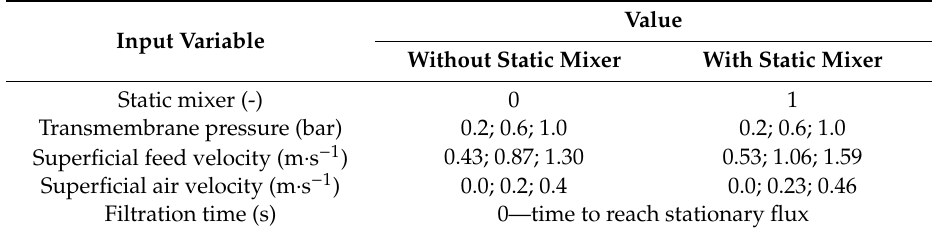
Table 1. Microfiltration experiments—input variables and their